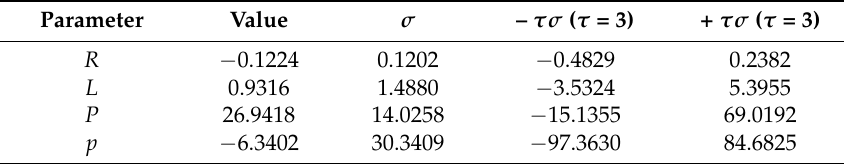
Table 4. Results from the analysis of the vertical displacement of point